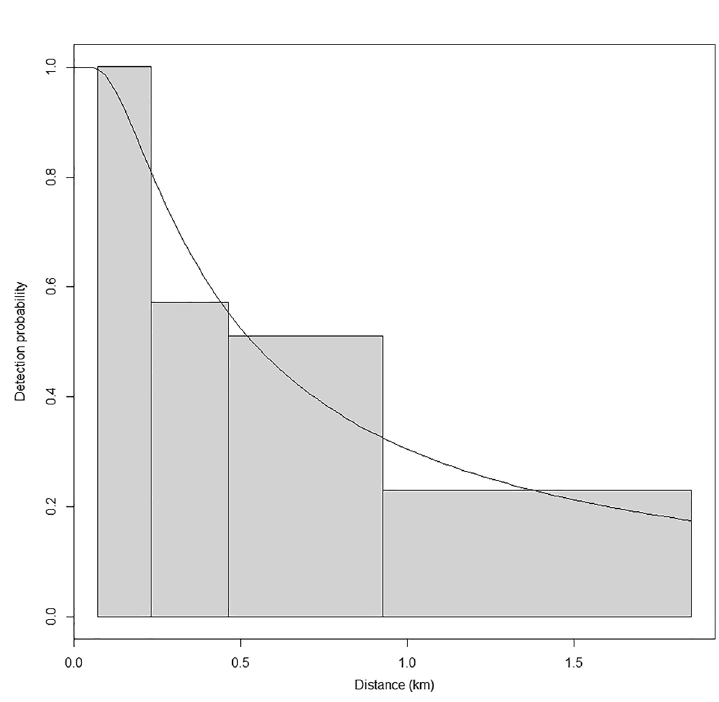
Figure 2. Right whale detection function derived from survey effort conducted between 2011 and 2019. The line represents the fitted detection function. Bars represent the frequency of sightings in predefined distance